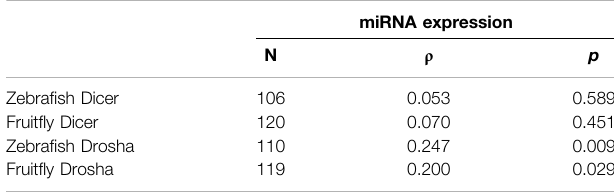
TABLE 1 | Correlation between Dicer and Drosha cleavage ef fi ciencies and global miRNA expression in vivo . Sample size (N), Spearman ’ s correlation coef fi cient ( ρ ), and p values are listed. Correlationswith p < 0.05 are marked in red. Rawdata are presented in Supplementary Tables S1 – S4